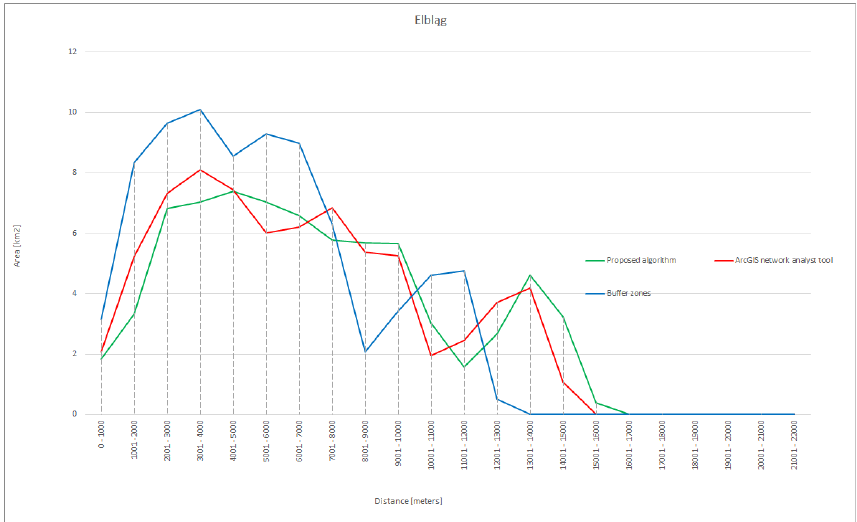
Figure 16. The results generated by different methods for identifying service areas in the city of Elbl ˛ag. The presented lines have a parabolic shape which supports the determination of the maximum values. Their parabolic shape can be attributed mainly to the irregular boundaries of area A and the location of base point U. The lines presenting the results of the analysis conducted with the use of the proposed methodology are flattest and most elongated. The above indicates that service areas determined based on a given area are smaller than the areas determined with the standard method or the buffer method. The service area determined in the proposed method is smallest because linear barriers decrease accessibility. The green line covers the longest distance on the horizontal axis. The service area around a point located on the boundary of the analyzed area is characterized by a higher cost